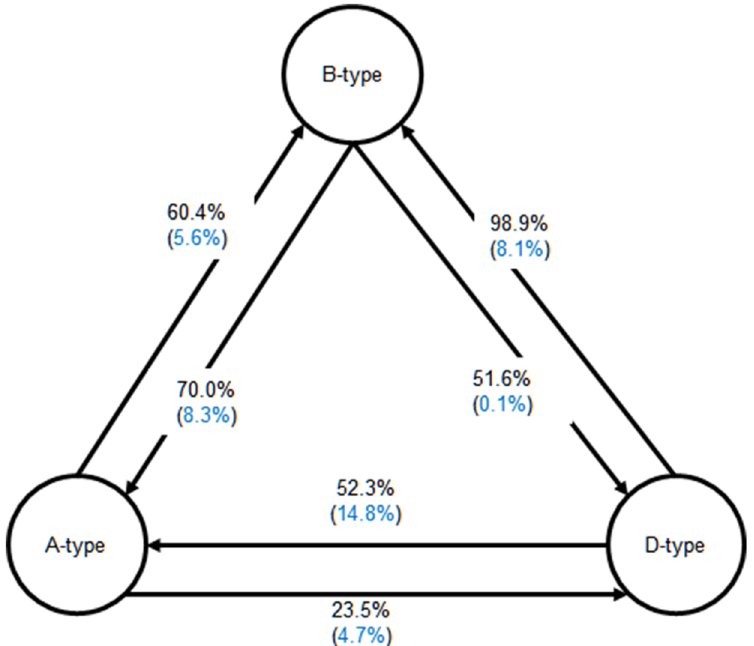
Fig 2. Relationship among the three types of KMEDs. Black: % of the (starting point) KMED articles that are also categorized into the (ending-point) KMED. Blue: % of the articles that are not the (starting point) KMED but that are categorizedinto the (ending-point)